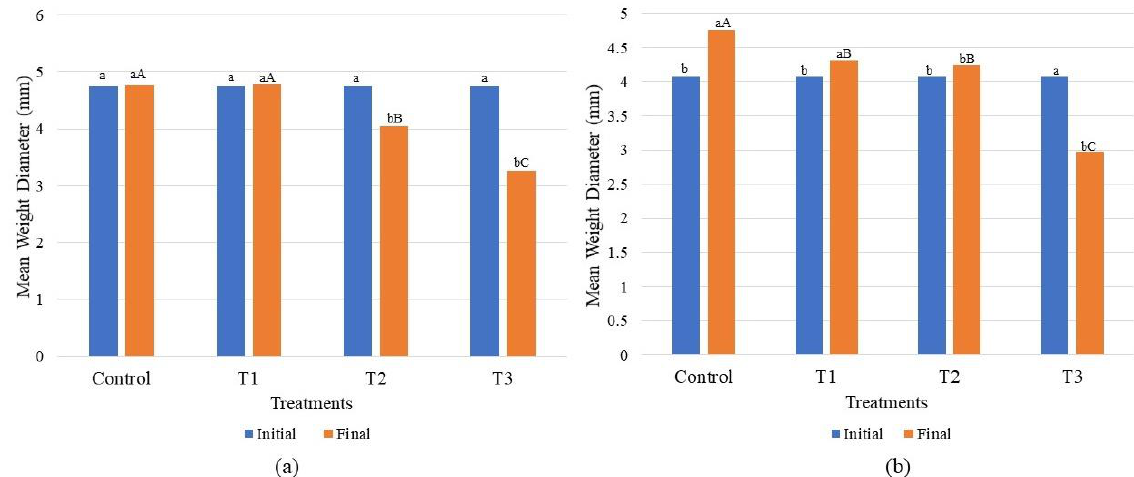
Figure 1. Comparison of Mean Weight Diameter (MWD) between the initial and final weeks of the 17-week growing period for different treatments in (a) hemic and (b) sapric peat materials. Capital letters indicate mean separation among treatments, while lowercase letters refer to mean separation within treatments using Tukey at p=0.05.